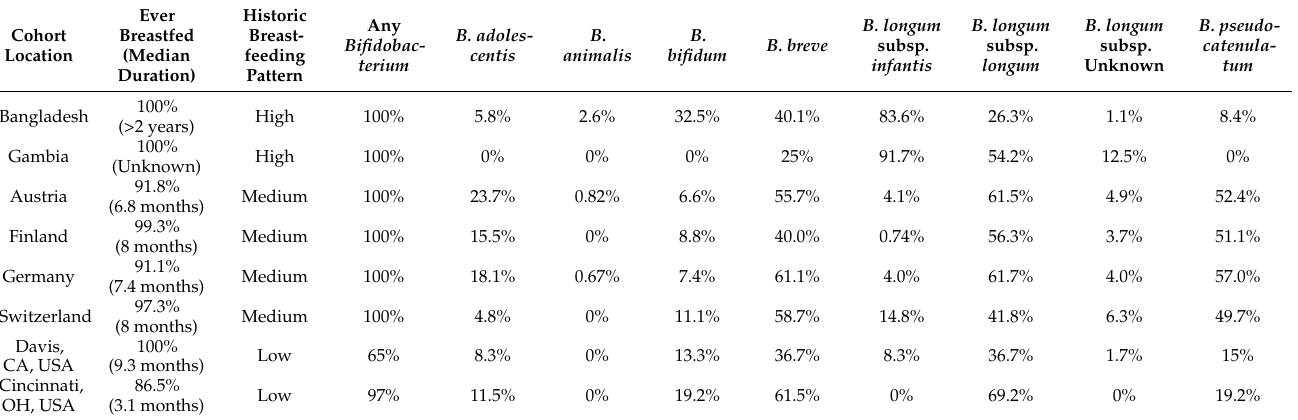
Table 2. Summary of Bifidobacterium prevalence in infants aged 1 to 2 months. Except for informa- tion on breastfeeding initiation and duration in a cohort, values are based solely on infants who were breastfed. The breastfeeding initiation (ever breastfed) rate and breastfeeding duration were calculated using data from all infants in a cohort with an available sample and a known breastfeed- ing